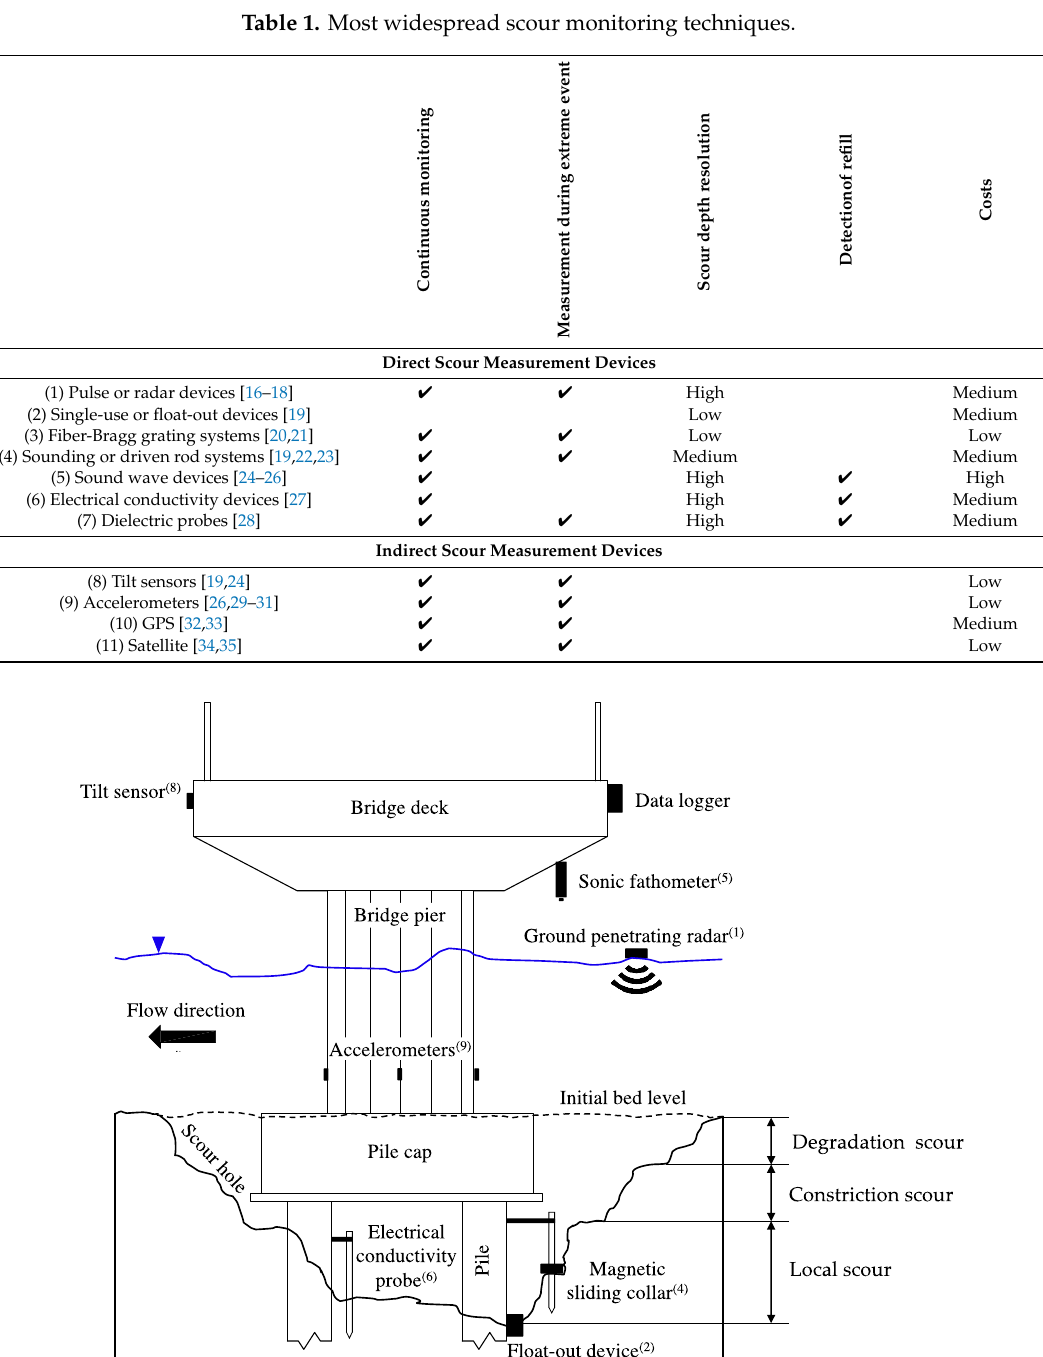
Figure 1. Schematic illustration of type of scour and bridge scour monitoring devices.